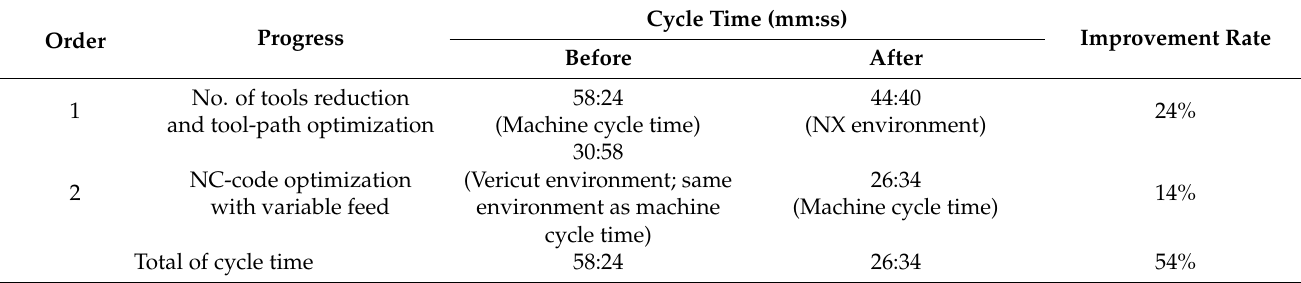
Table 7. Cycle time